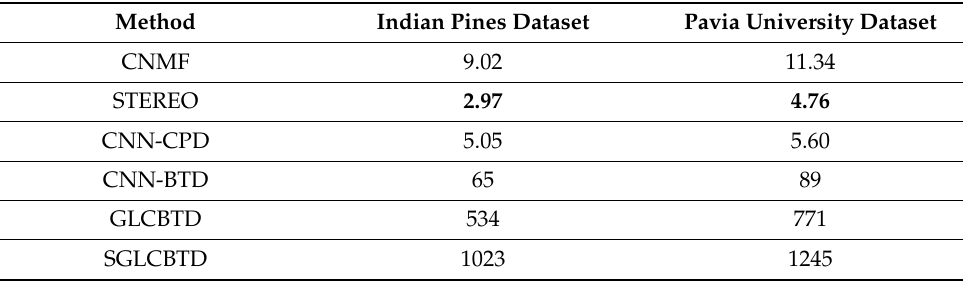
Table 3. Computational time of the compared methods